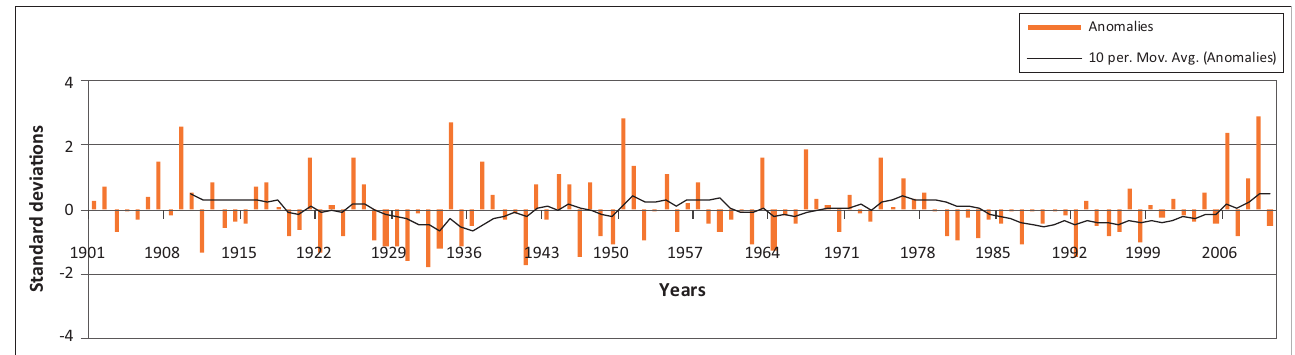
FIGURE 8: Standardised anomalies of the spatial (regional) averaged CRU data with a 10–year moving average trend line.